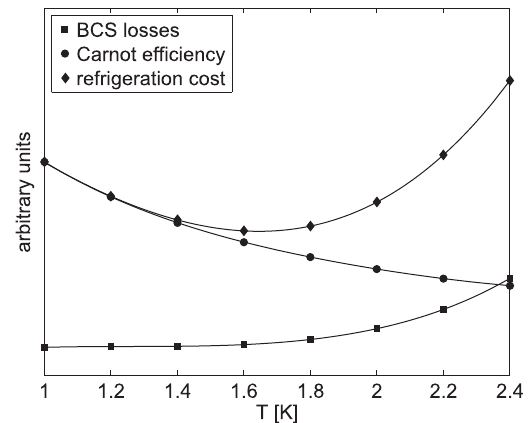
FIG. 1. Optimal operating temperature for superconducting rf cavities